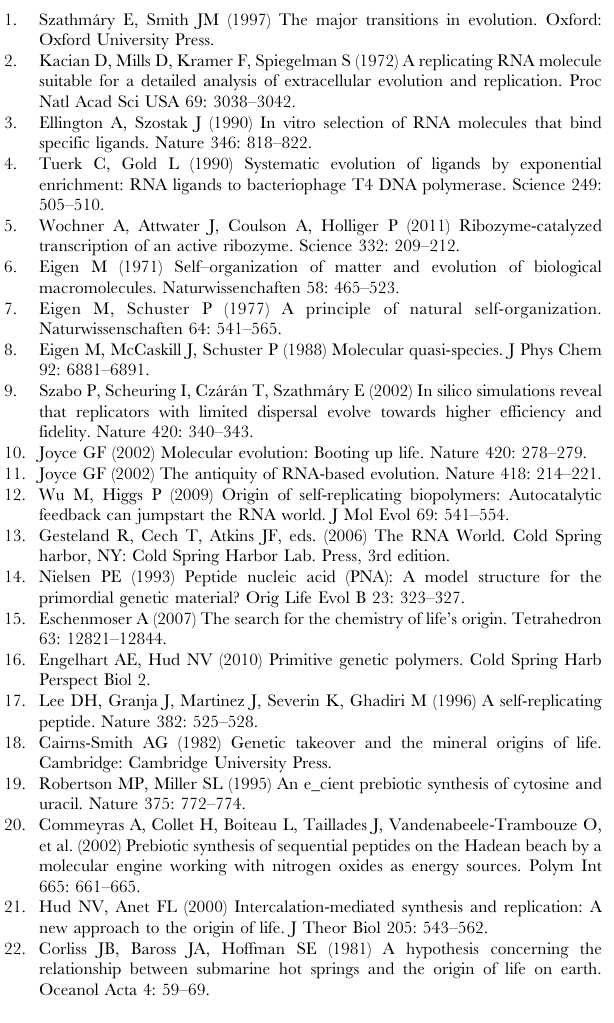
Table S1 Parameters and values used in